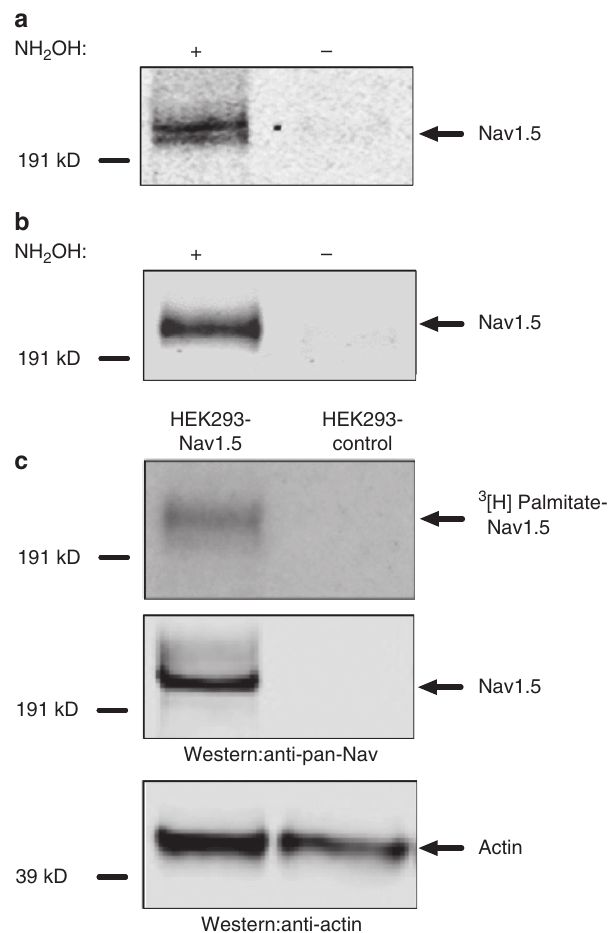
Figure 2 | Cardiac sodium channels are post-translationally modified by protein palmitoylation. Three distinct methods were utilized to detect protein palmitoylation: acyl-biotin exchange ( a , b ), metabolic tritium labelling ( c ) and click chemistry (Supplementary Fig. 3). The results are representative of at least three independent experiments. ( a ) Nav1.5 is palmitoylated in cardiac tissues, where ‘ þ ’ (hydroxylamine treated group) indicates the existence of protein palmitoylation on Nav1.5 channels and ‘ (cid:2) ’ (tris treated group) serves as the negative experimental control. All the biotinylated proteins (previously palmitoylated proteins) were immunoprecipitated using a streptavidin pull down assay. A sodium channel pan antibody was used to detect transfected or endogenous sodium channel proteins. ( b ) Nav1.5 is also palmitoylated in HEK293 cells with stable expression of Nav1.5 channels. ( c ) Nav1.5 palmitoylation was identified after tritium-labelled palmitic acid treatment. Upper panel: tritium-labelled palmitoylated Nav1.5 was detected in HEK293 cells stably expressing Nav1.5, but not in control HEK293 cells; Middle panel: Nav1.5 was shown in western blot analysis using the same samples; Lower panel: comparable amount of actin from the same samples was shown in western blot analysis. derivatives of palmitic acid that can be detected with direct in-gel fluorescence analysis. Altogether, three lines of biochemical evidence support the conclusion that Nav1.5 is indeed palmitoylated in both the heterologous expression system and native cardiac tissue.